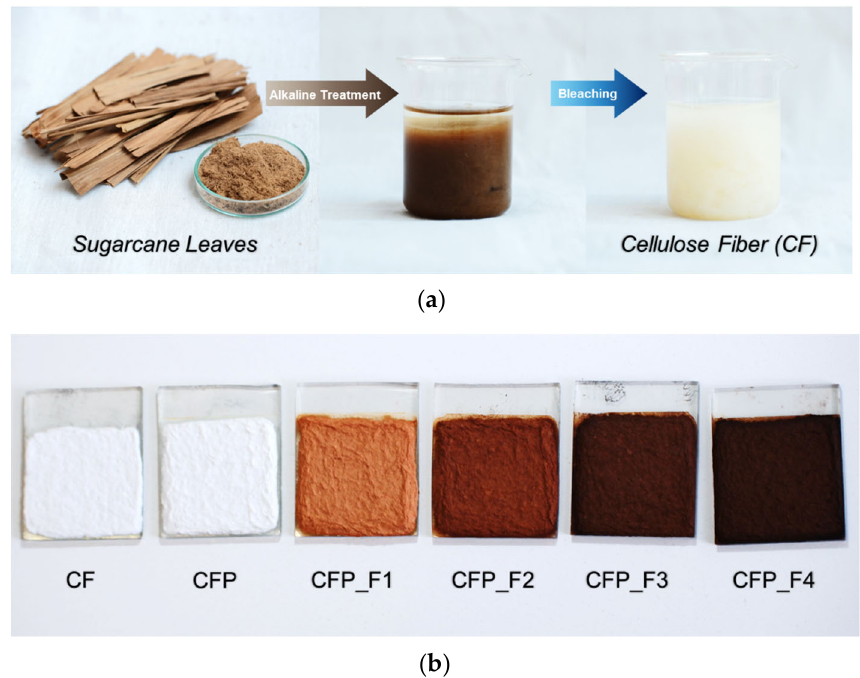
Figure 1. ( a ) The CF products after alkaline treatment and bleaching; ( b ) photographs of CF, CFP, CFP_F1-F4 on ITO substrates as tribopositive materials for TENG.